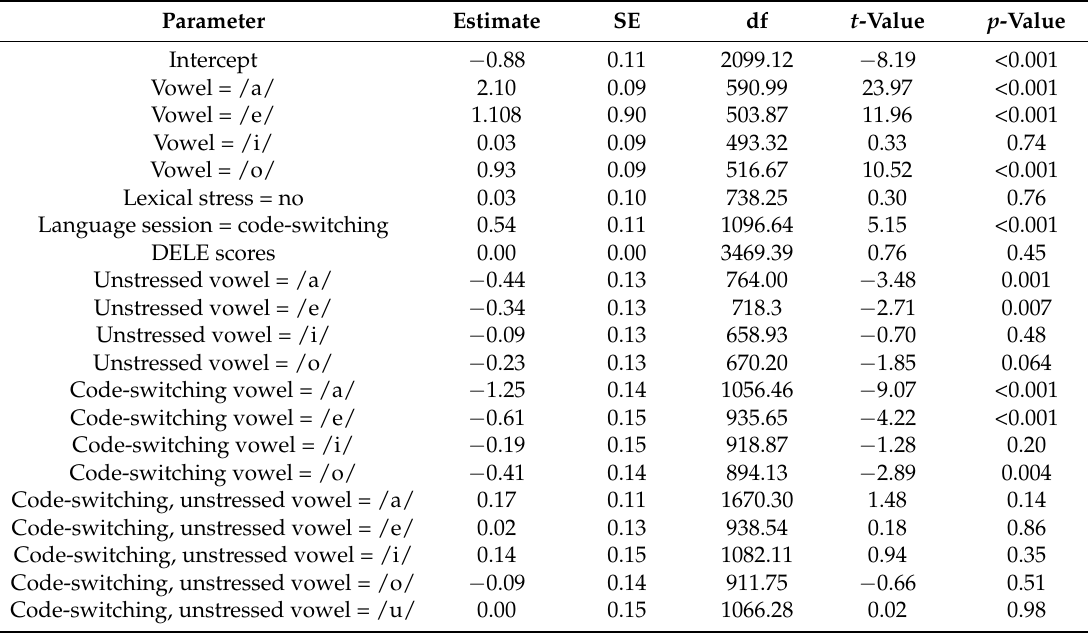
Table 3. Results from the linear mixed effects model for normalized F1